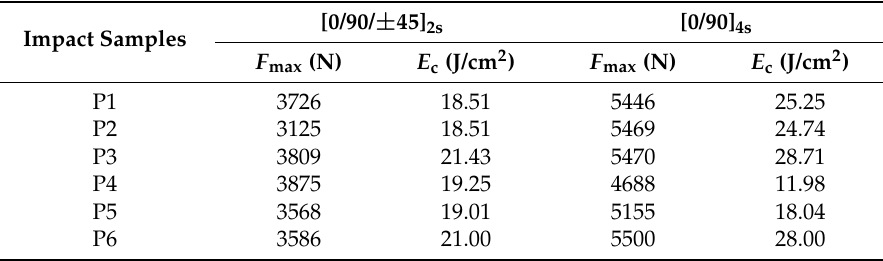
Table 4. Maximum force and maximum impact strength results of non-aged laminates subjected to an impact energy of 32.46 J.